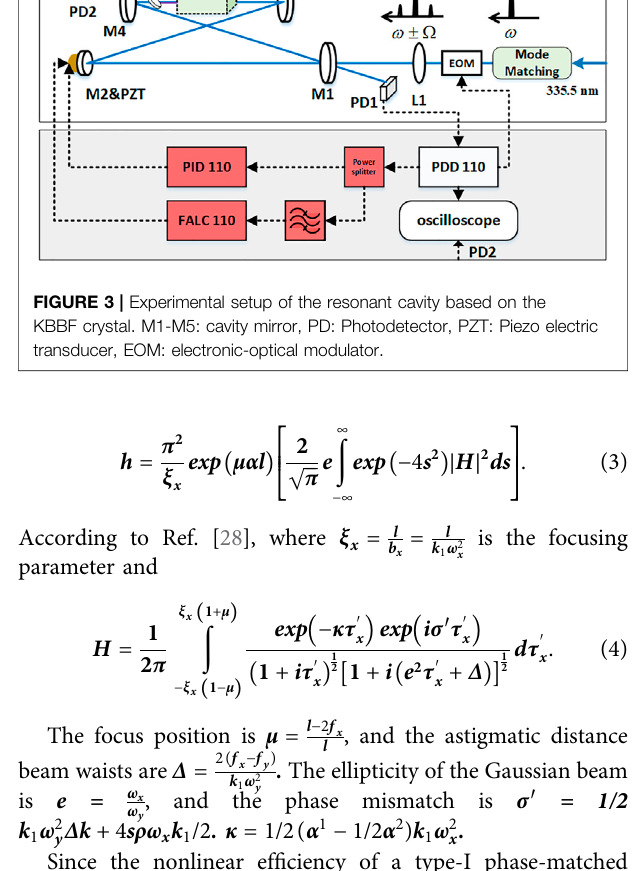
TABLE 1 | Parameters related to the KBBF crystal. Crystal